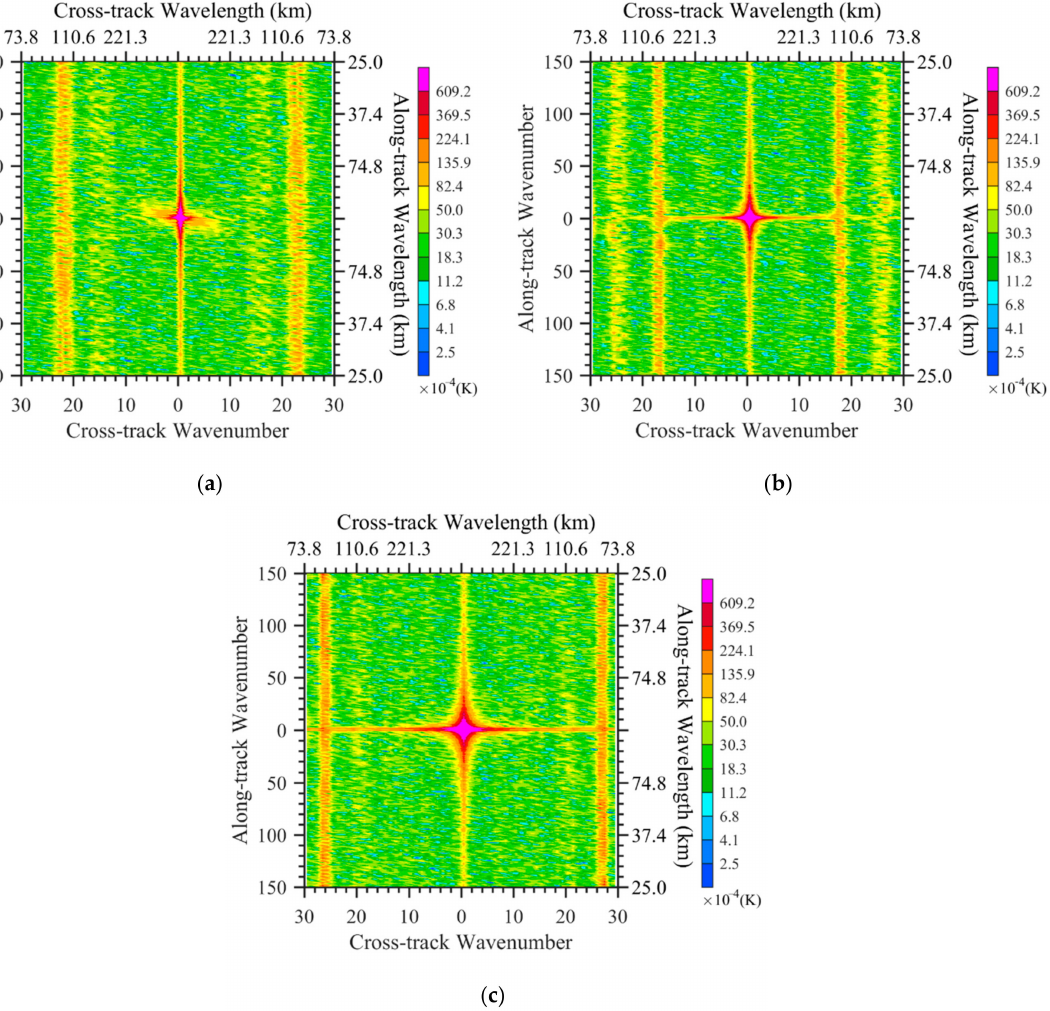
Figure 5. Variations of amplitude with respect to wavenumbers in cross- and along-track directions in areas ( a ) A, ( b ) B, and ( c )